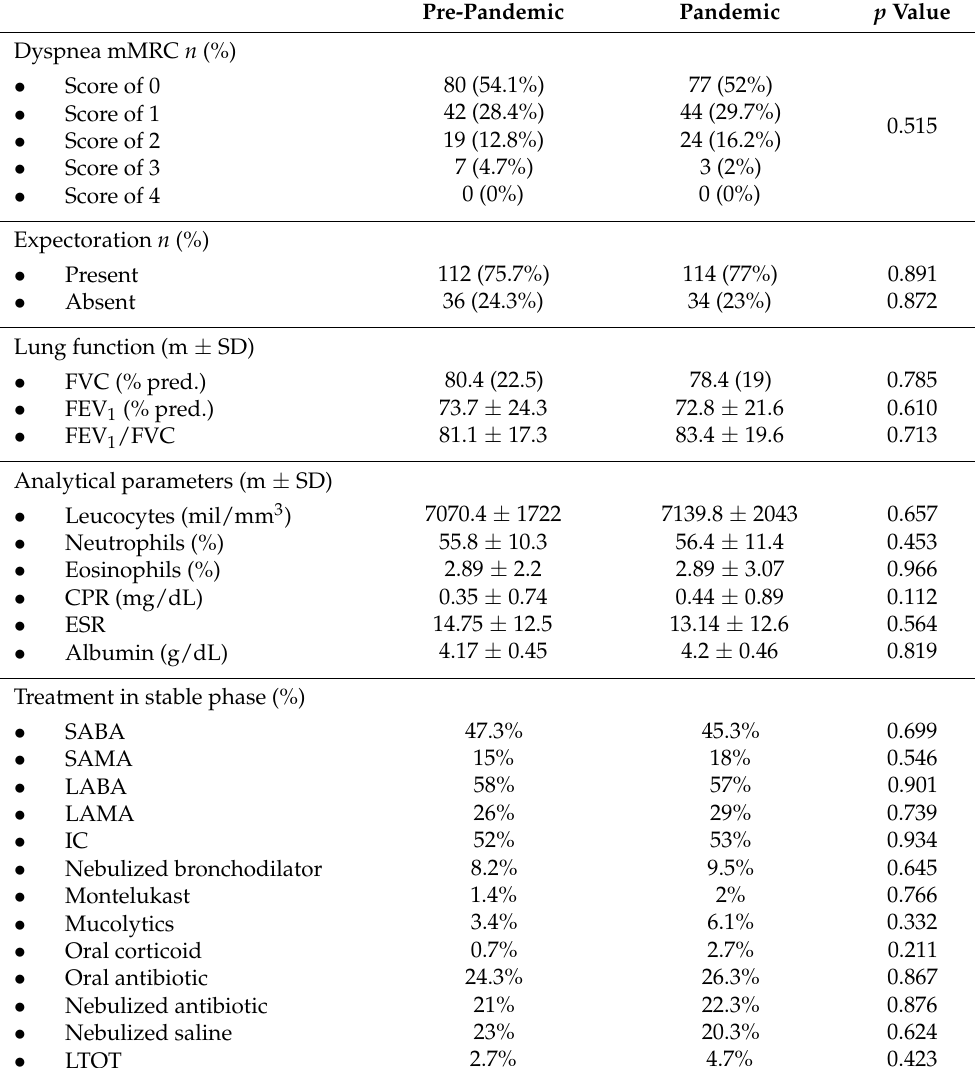
Table 5. Comparison of the symptoms, lung function, analytical parameters, and usual treatment in the pre-pandemic and pandemic